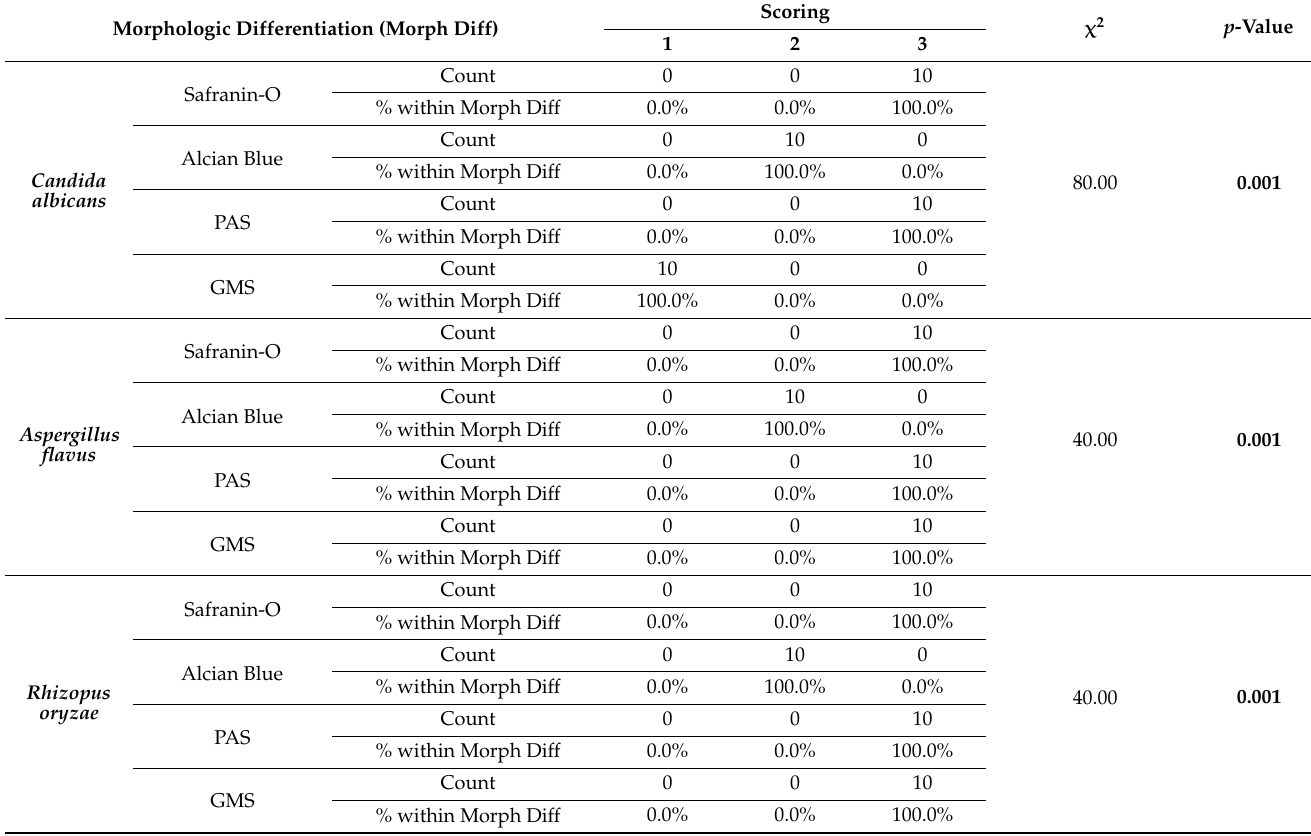
Table 4. Comparison of mean morphologic differentiation (spore size) of Candida albicans , Aspergillus flavus and Rhizopus oryzae